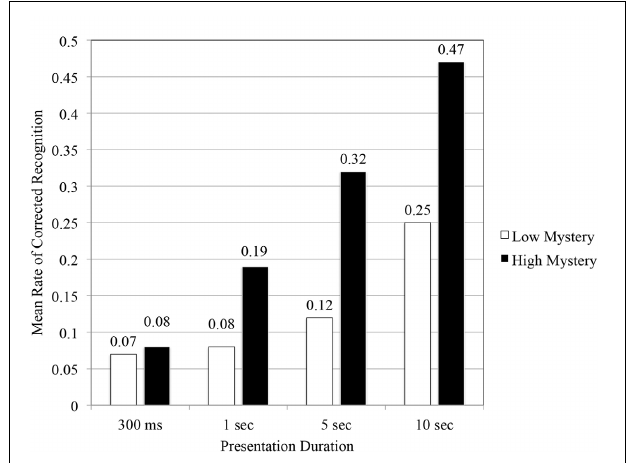
FIGURE 4 | Mean rate of corrected recognition as function of scene type and presentation duration.